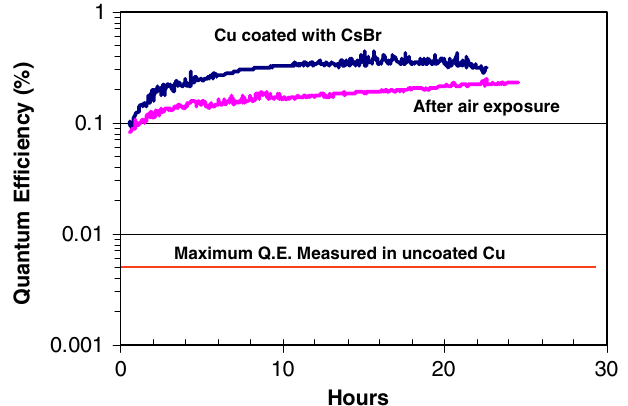
FIG. 5. (Color) Quantum efficiency (%) at 257 nm of the CsBr = Cu sample as deposited and after exposure to air for 1 min and pumped down to low pressure without bakeout. The CsBr = Cu sample was treated with HCl and deionized water prior to CsBr deposition. The sample was irradiated at 1 (cid:4) 10 5 W = cm 2 with a 257 nm laser at a pressure of 5 (cid:4) 10 (cid:1) 10 Torr , and shows a greater quantum efficiency than the untreated sample shown in Fig. 4. The quantum efficiency enhancement is more than 50-times relative to the maximum value obtained in the solid Cu target. The maximum Q.E. for the uncoated Cu sample is shown in the figure for comparison to the CsBr = Cu